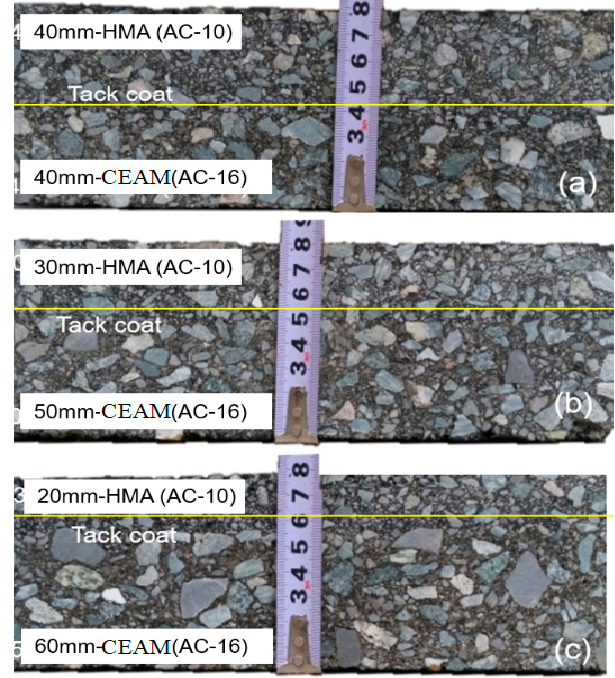
Figure 2. Pictures of different thickness structure combinations: ( a ) C1; ( b ) C2; and ( c ) C3.